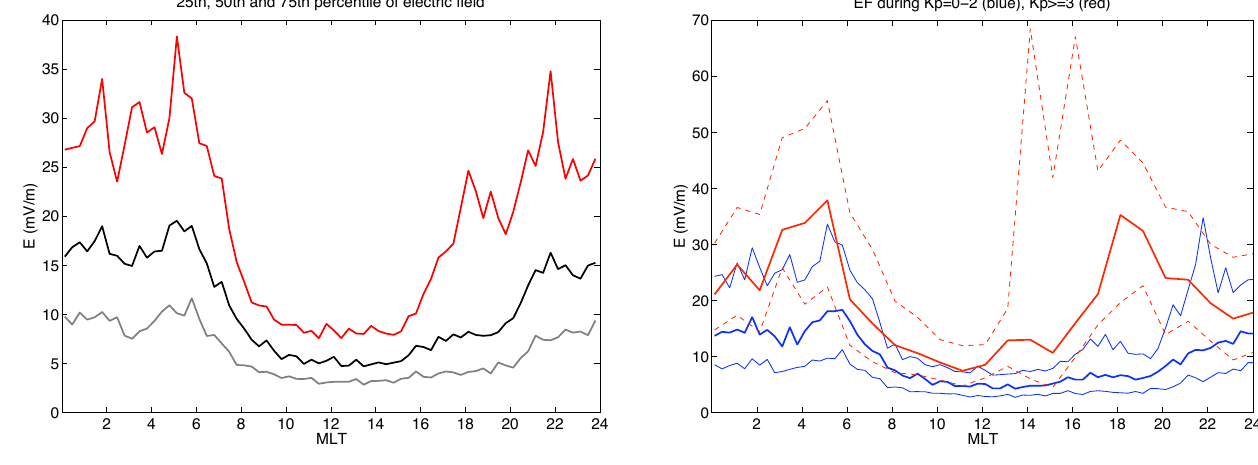
Fig. 7. Total electric field, same format as Fig. 3. Fig. 8. Total electric field, same format as Fig.